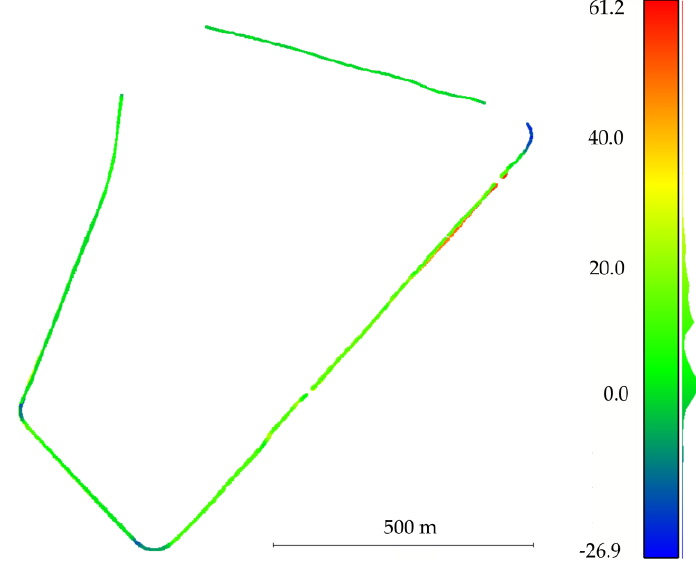
Figure 14. The error of course determination by a satellite compass m HDG [ ◦ ], with the orientation relative to the direction of the tramway journey.